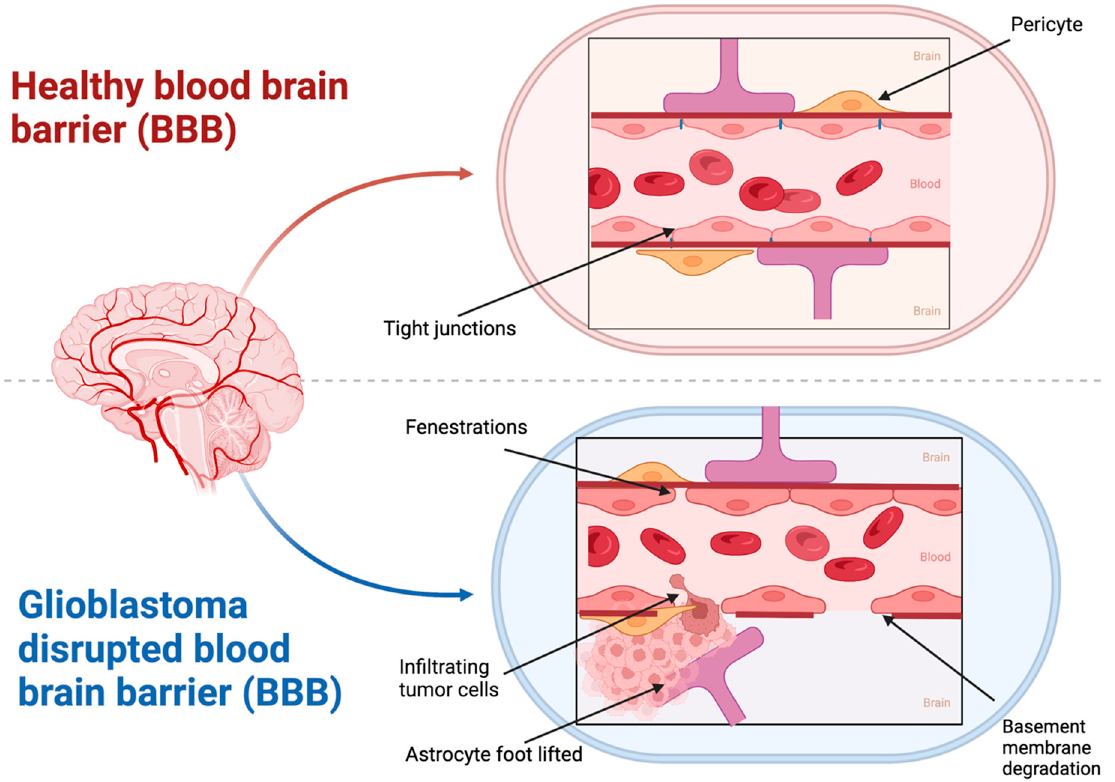
Figure 2. The depiction of the characteristic of a healthy BBB versus a disrupted BBB in GBM (created by Bio Render).